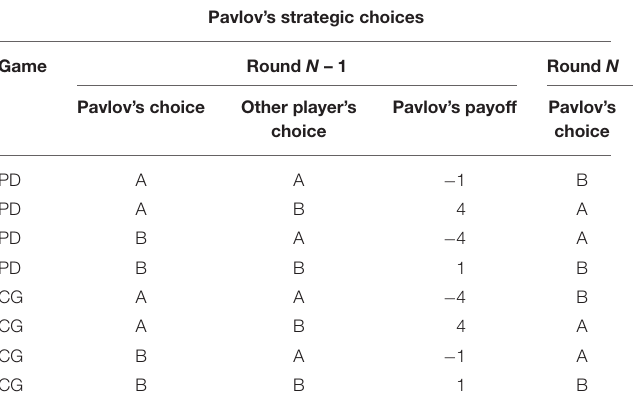
TABLE 3 | Choices that the Pavlov-Tit-For-Tat (PT4T) strategy would make on round N during both Prisoner’s Dilemma (PD) and Chicken Game (CG) based on the previous choice (round N – 1) of both the strategy and other